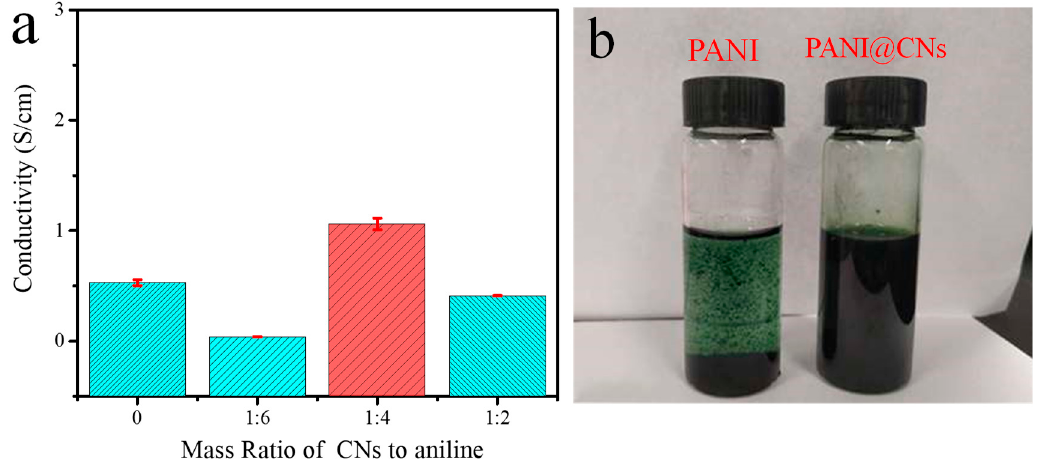
Figure 5. ( a ) Electrical conductivity of PANI@CNs with different feeding mass ratios of CNs/aniline, ( b ) dispersion test of PANI, and PANI@CNs (1:4) in 1,4-dioxane.